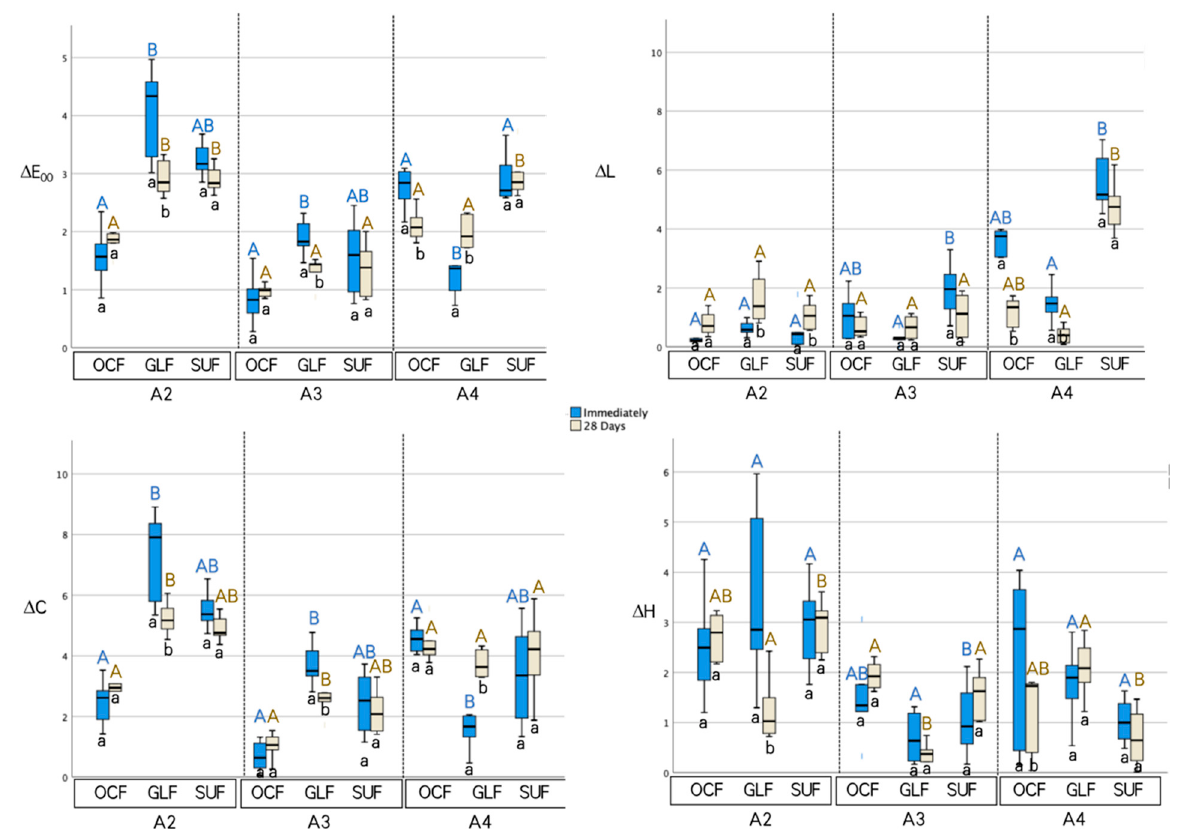
Figure 2. Box-and-whisker plots for the ∆ E 00 , ∆ L, ∆ C, and ∆ H values of three flowable resin composites at A2, A3, and A4 shade immediately and after 28 days of storage. Different upper-case letters show statistical differences between three different materials. Different lower-case letters show a statistical difference between different aging procedures.